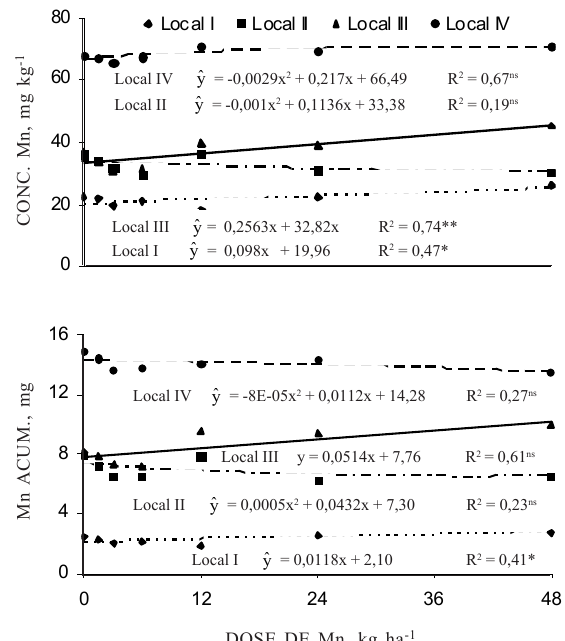
Figura 7. Concentração e acúmulo de manganês na parte aérea das plantas de soja, nos quatro locais, considerando as doses de manganês aplicadas. Local I: Faz. Santa Rosa; Locais II e